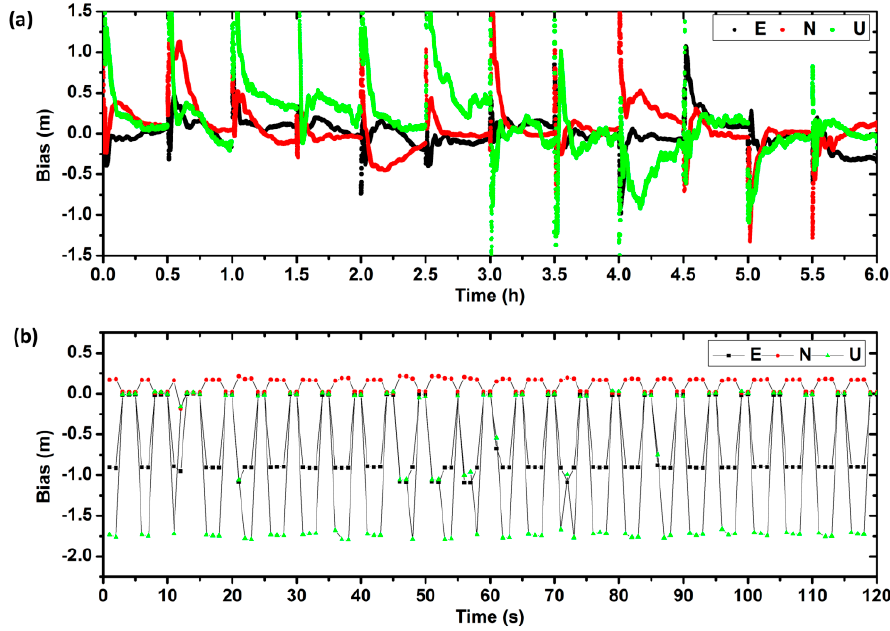
Figure 4. The convergence of the PPP/RTK (( a , b ) represents the results of PPP and URTK, respectively). Table 4. The statistics of the average convergence time (Unit: